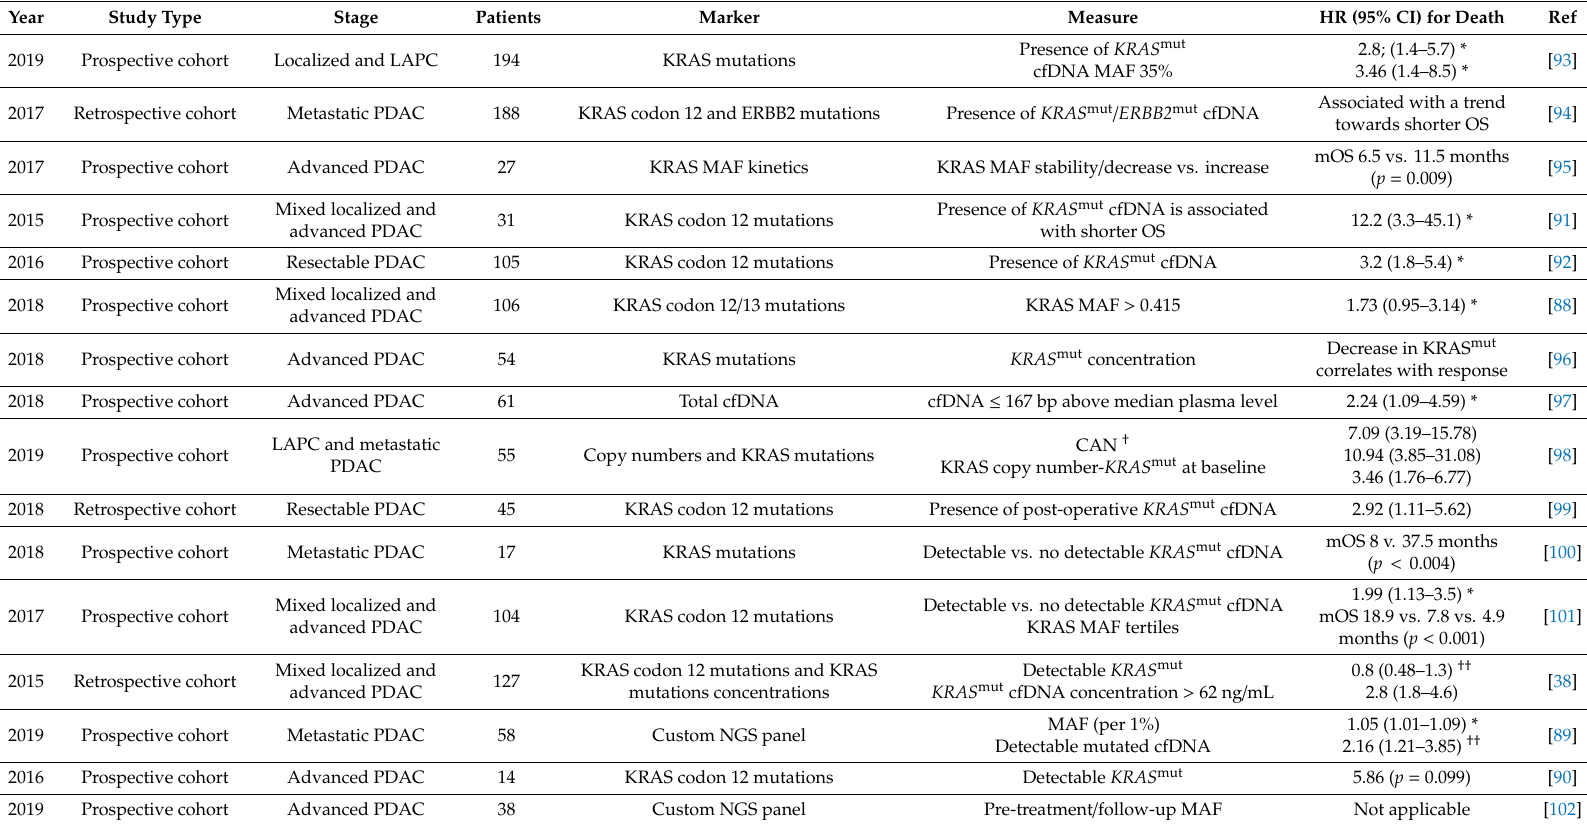
Table 2. Plasma cell free DNA (cfDNA) and prognosis among patients with